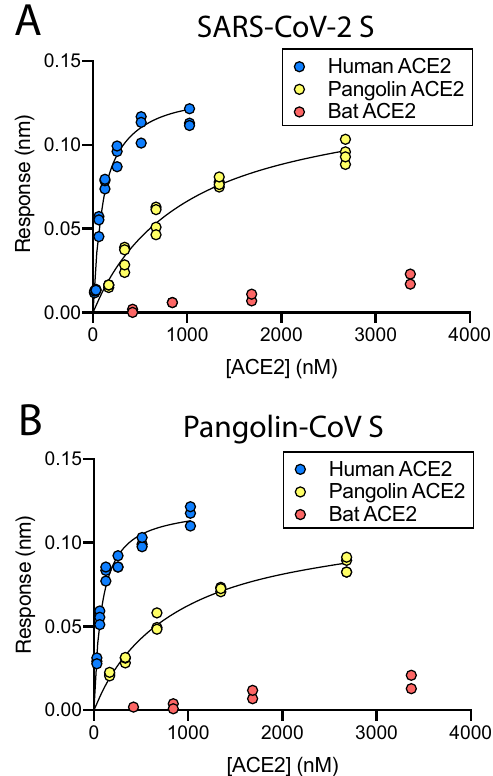
Fig. 1 Binding of Pangolin-CoV and SARS-CoV-2 S to ACE2s from different species. Plots of biolayer interferometry amplitudes for human (blue), pangolin (yellow) and bat (red) ACE2s binding to SARS-CoV-2 S ( A ) and Pangolin-CoV S ( B ). Table 1 Binding of Pangolin-CoV and SARS-CoV-2 S to ACE2s from different species.